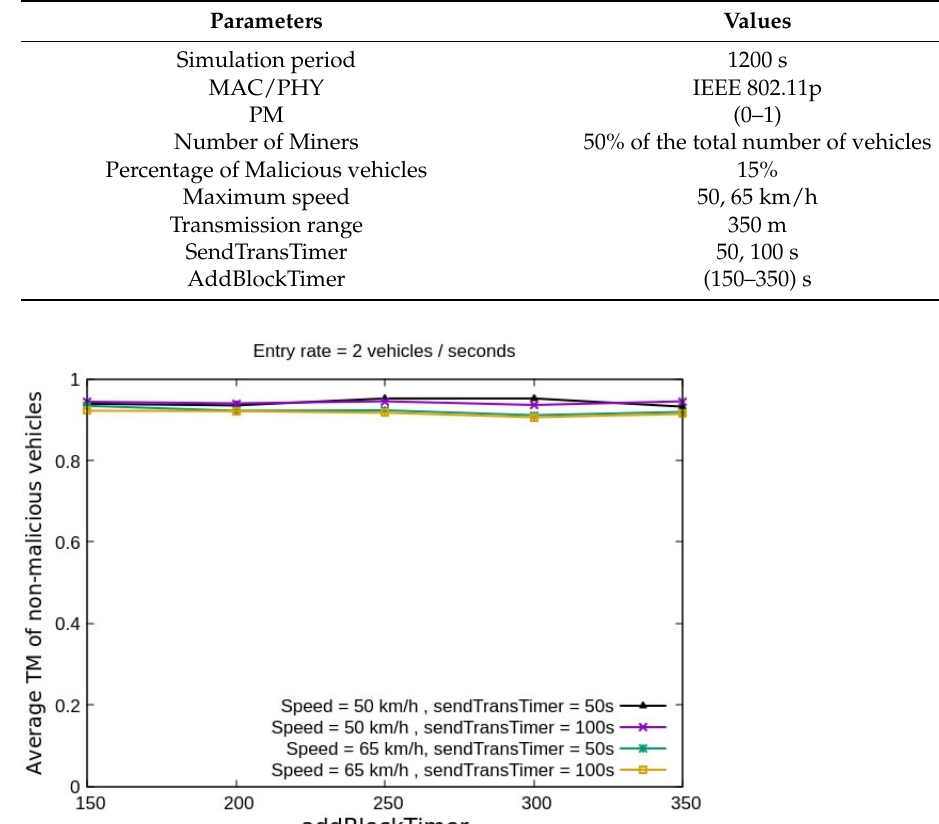
Figure 4. The average trust metric of non-malicious vehicles as a function of addBlockTimer(s), entry rate = 2 vehicles/s .